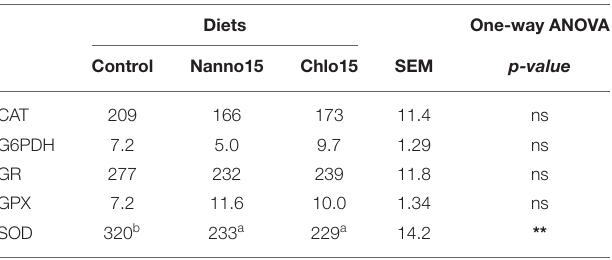
229 a 14.2 ** Values presented as means (n = 12) and pooled standard error of the mean (SEM). Different letters in the same row stand for statistical differences between diets (p ≤ 0.05). ns, non-significant (p > 0.05); ** p ≤ 0.01.